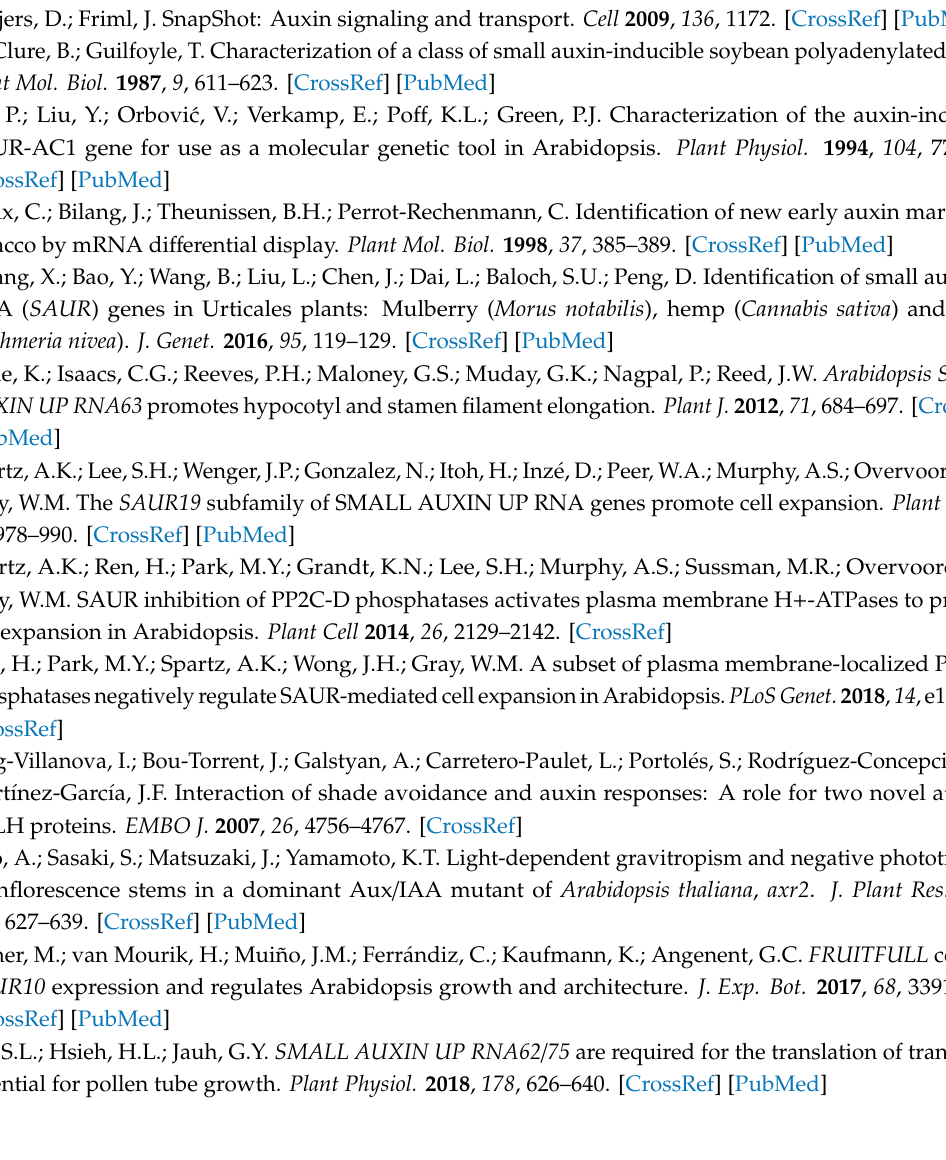
Figure S1: Alignment of SAUR proteins in the five plant species, Table S1: Primers for qRT-PCR analysis. Table S2: Details of SAUR genes in Agave